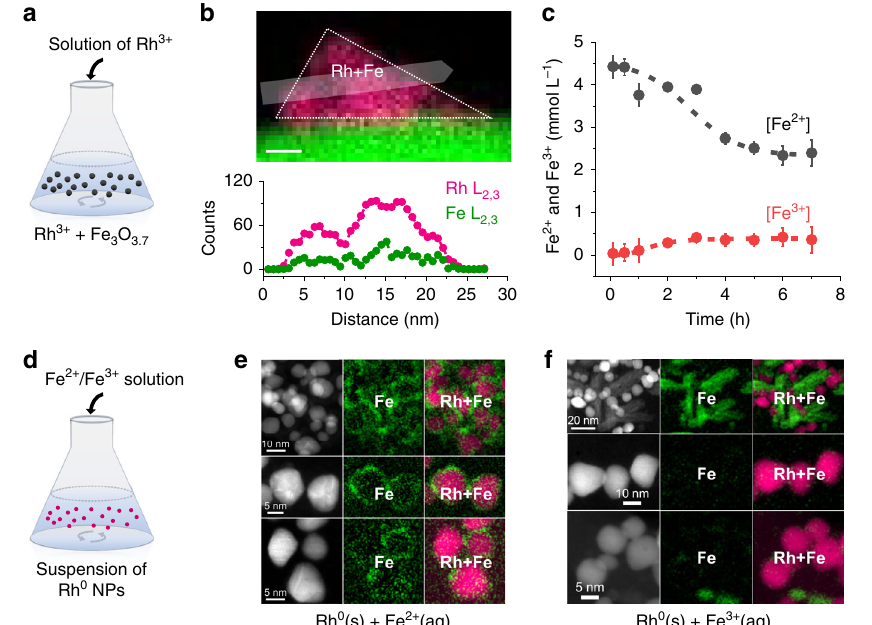
Fig. 1 Synthesis of FeO x /Rh/Fe 3 O 4 by galvanic replacement and reference experiments to elucidate the mechanism of FeO x coating on Rh. Synthesis of FeO x /Rh/Fe 3 O 4 -fresh by galvanic replacement, where powder Fe 3 O 3.7 is contacted with a solution containing Rh 3 + ( a ). Rh and Fe L-edges EELS images of the FeO x /Rh/Fe 3 O 4 -fresh and the corresponding line-scan pro fi le showing the FeO x coating on Rh; the scale bar is 5 nm ( b ); more images can be found in Supplementary Figs. 2 – 5. Evolution of concentrations of aqueous Fe 2 + and Fe 3 + when Fe 3 O 3.7 is contacted with the Rh 3 + solution ( c ). Scheme of the reference experiments, where pre-formed Rh nanoparticles were contacted with solutions containing Fe 2 + or Fe 3 + ( d ). HAADF-STEM-EELS images of the solids produced after contacting Rh nanoparticles with Fe 2 + ( e ) or Fe 3 + ( f ) in solution showing the selective adsorption of Fe 2 + on Rh producing the Fe(II)- oxyhydroxide adlayers on Rh.